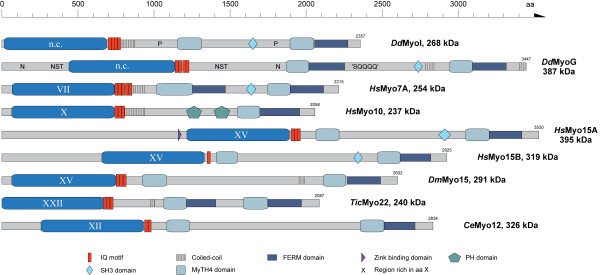
Domain organisation of examples of class-VII, -X,-XV, and -XXII myosins. The class designation is given in the motor domain of the respective myosin in Roman numerals. A colour key to the domain names and symbols is given on the bottom except for the myosin domain that is coloured in blue. For comparison, a myosin of class-XII is shown because its tail also contains MyTH4 and FERM domains, although class-XII myosins phylogenetically do not group at all to the other classes shown.